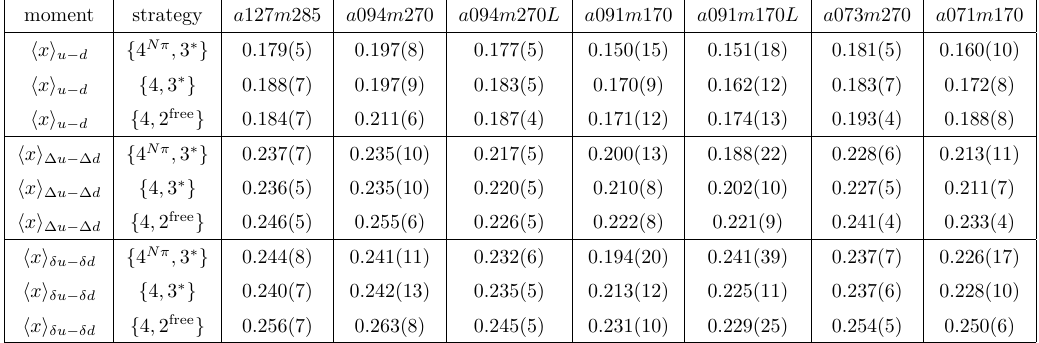
Table 11 . Renormalized moments for all three fit-strategies with Z factors obtained using Method A defined in this appendix C.